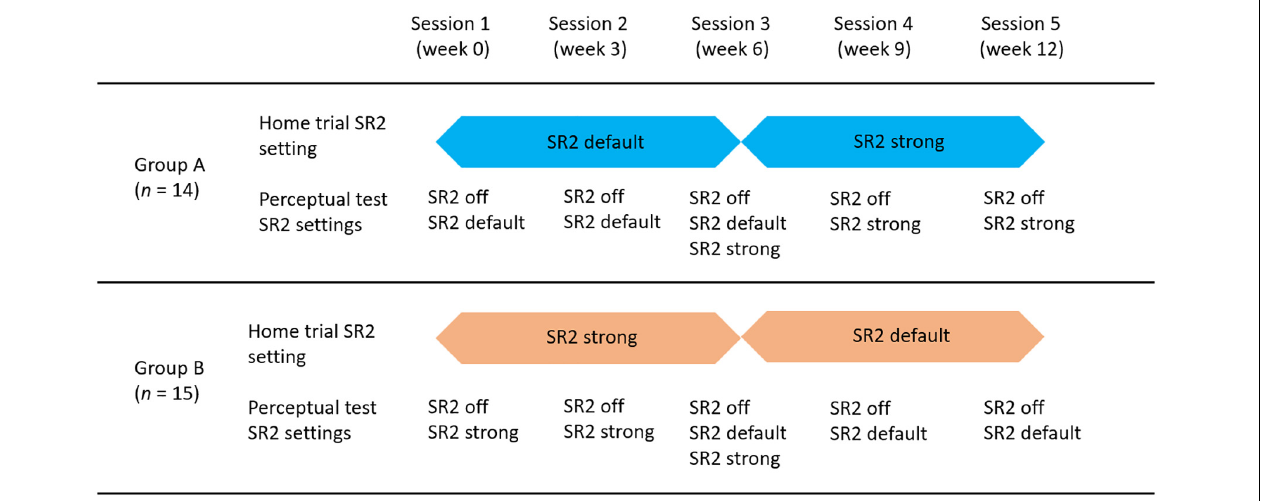
sound quality including loudness, clarity, naturalness, and overall quality using a continuous bar with two ends being 0 (extremely poor) and 10 (perfect). No practice was provided for this